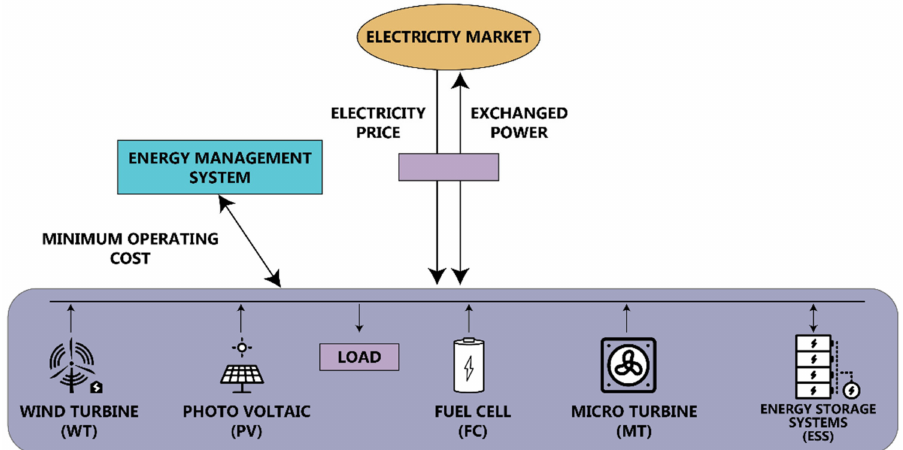
Figure 3. Power trading with the grid and electricity